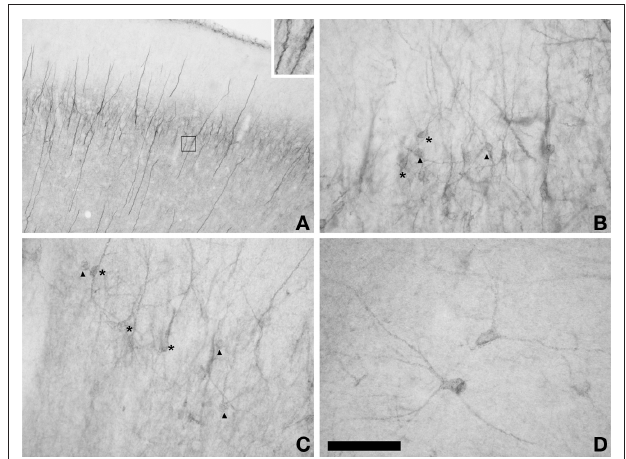
Figure 2 | Distribution of PSA-NCAM ir cells in the cat cerebral cortex. (A) Panoramic view of PSA-NCAM expression in the cat temporal cortex showing the presence of a dense band of immunostained cells in layer II. Note the characteristic vertical processes located in this cortical region. Inset in top right of the photograph shows two vertical processes to which three PSA-NCAM expressing small round somata are apposed. (B,C) Detailed view of PSA-NCAM immunoreactive cells in layer II of cat temporal cortex. Observe the different morphologies displayed by S cells: tangled (arrowheads) and semilunar–pyramidal transition cells (asterisks). (D) PSA-NCAM expressing L cells in deep layers of the cerebral cortex displaying multipolar or bipolar morphology. Scale bars: 300 μm for (A) , 60 μm for (B–D) . Inset in (A) is a 3 × magnification of the boxed